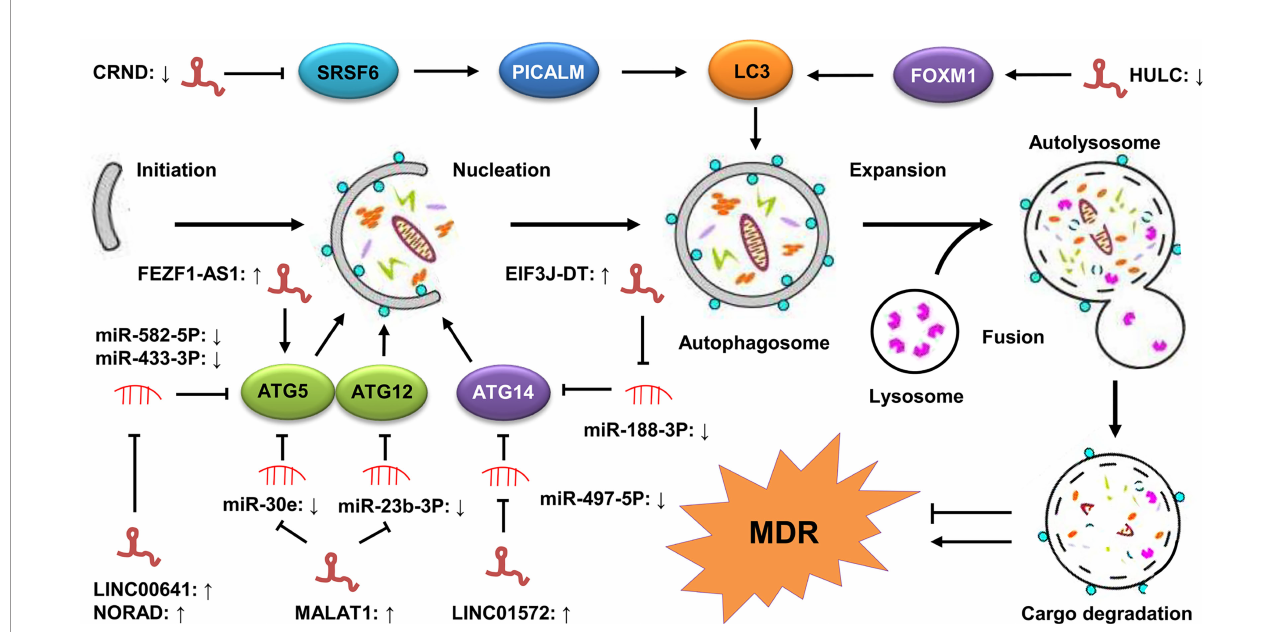
FIGURE 4 | LncRNAs regulate autophagy-mediated GC drug resistance. The process of autophagy contains fi ve steps, including initiation, vesicle nucleation, vesicle expansion, vesicle fusion, and cargo degradation. These steps are tightly regulated by a series of ATGs, including ATG5, ATG12, ATG14 and LC3. LncRNAs are involved in autophagy-mediated MDR of GC cells by modulating the expression of these ATGs via sponging miRNAs or directly targeting them.